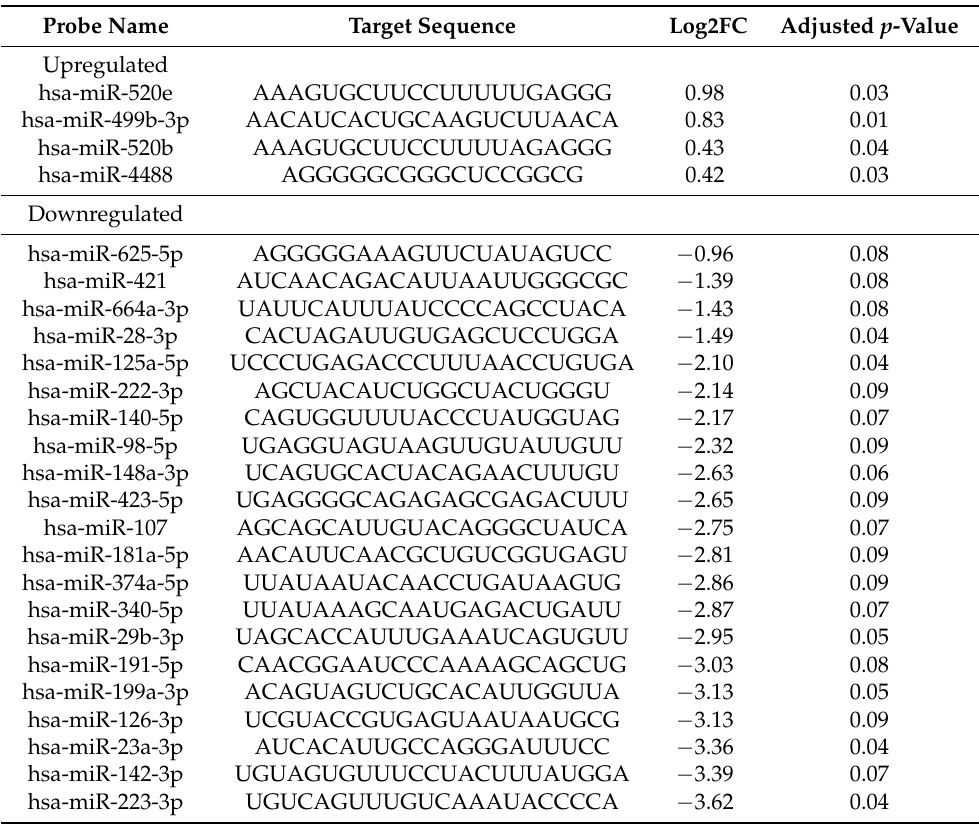
Table 2. Dysregulated ExomiRNAs following Chronic